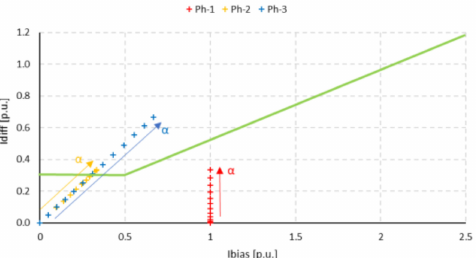
Figure 11. Non-standard phase shift influence on differential function 87T.